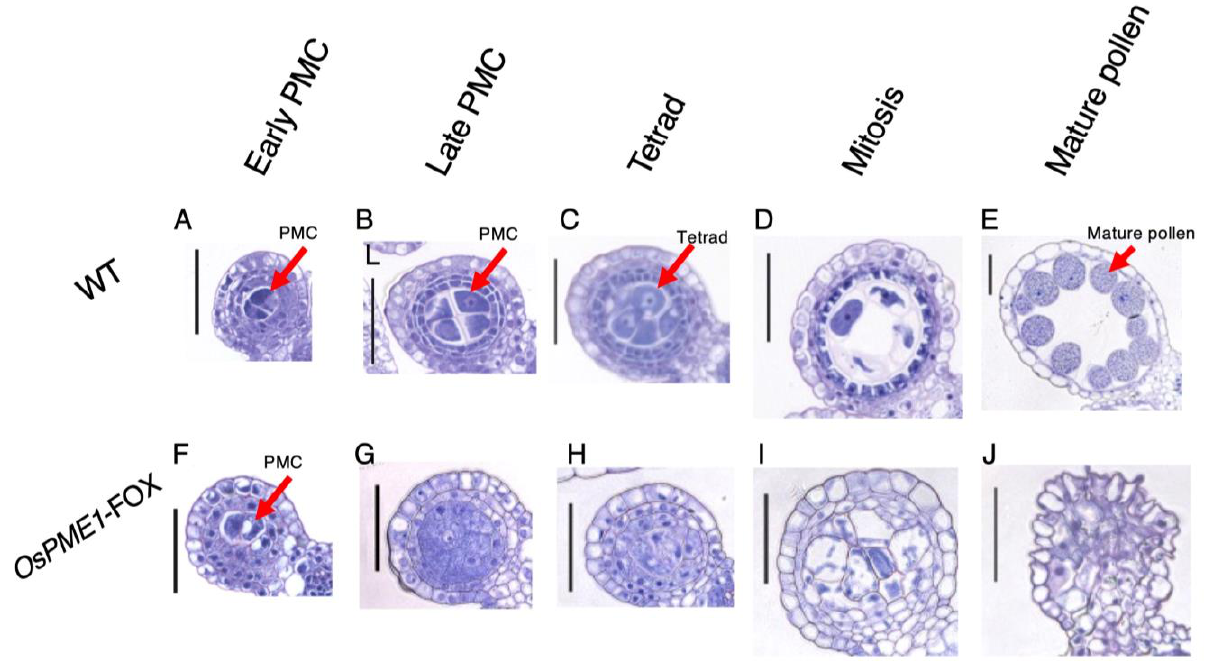
Figure 5. Abnormal pollen development of OsPME1 -FOX. Sections were stained with toluidine blue O. ( A – E ; WT) and ( F – J ; OsPME1 -FOX). All experiment was biologically repeated at least four times independently with similar results. PMC, pollen mother cell. Bars, 50 µm.